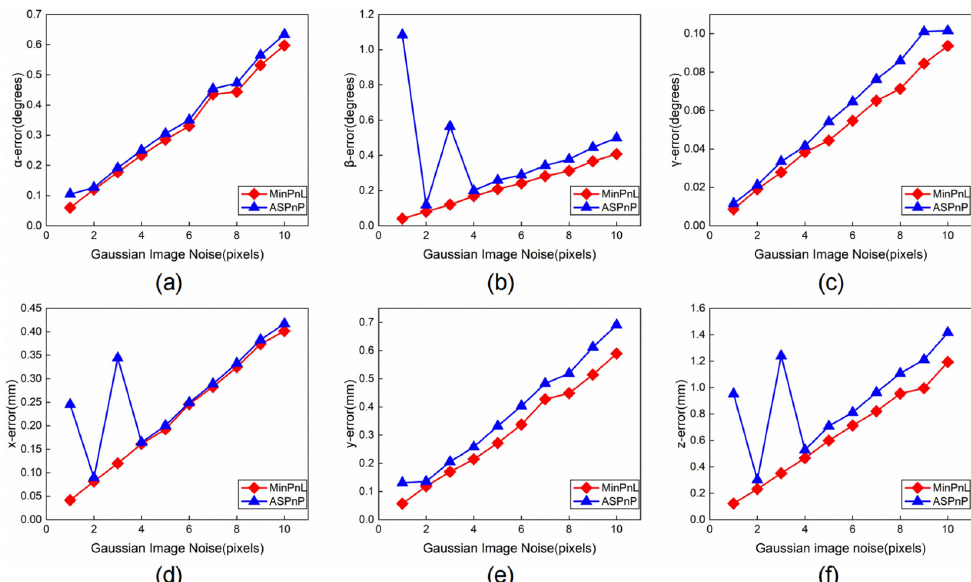
Figure 15. Accuracies of the MinPnL algorithm and the ASPnP algorithm when noise level changes: ( a ) The rotation error in roll ( α ) direction; ( b ) The rotation error in pitch ( β ) direction; ( c ) The rotation error in pitch ( γ ) direction; ( d ) The translation error in X-axis direction; ( e ) The translation error in Y-axis direction; ( f ) The translation error in Z-axis direction.